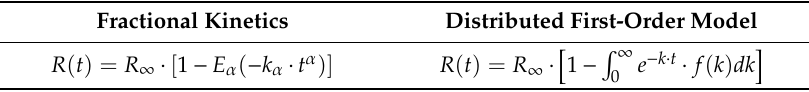
Table 6. Fractional kinetics versus its first-order